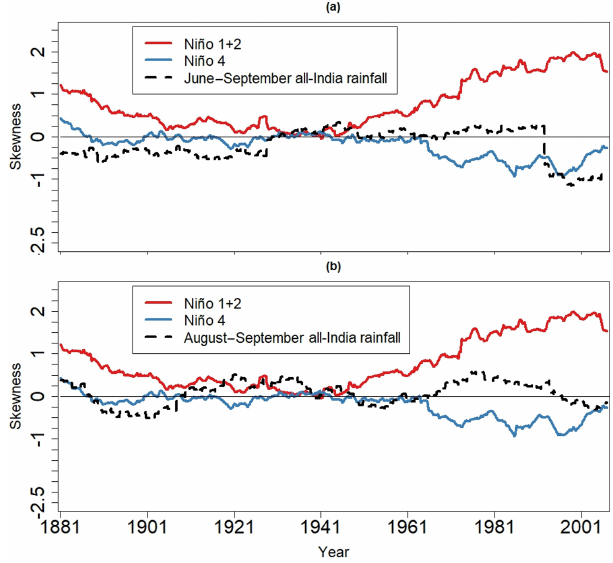
Figure 3. The time series of the (a) Niño 1 + 2 and (b) Niño 4 indices.